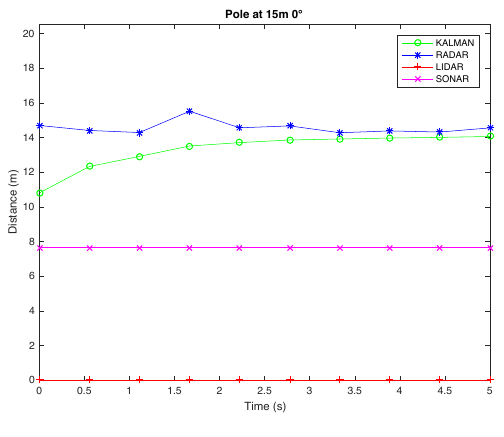
Figure 15 Pole at 15m distance, 0° Angle